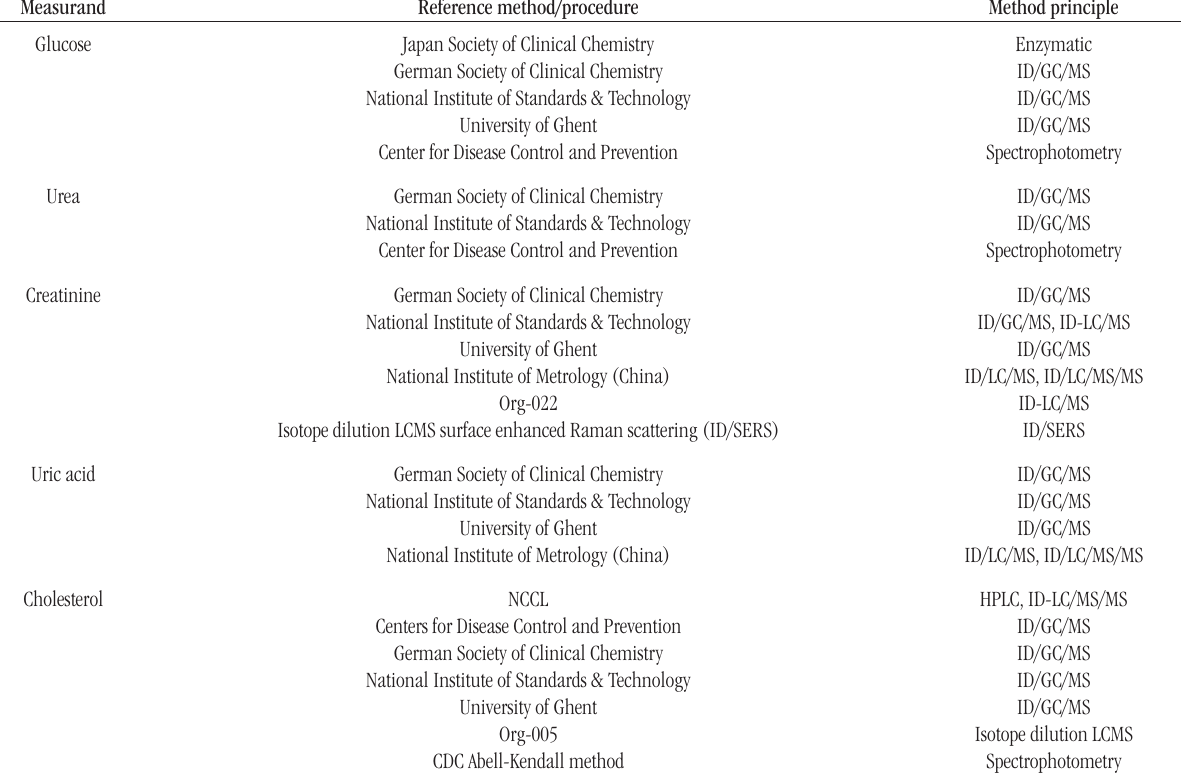
taBLE 4 − List of RMets for the measurands glucose, urea, creatinine, uric acid, and cholesterol Measurand